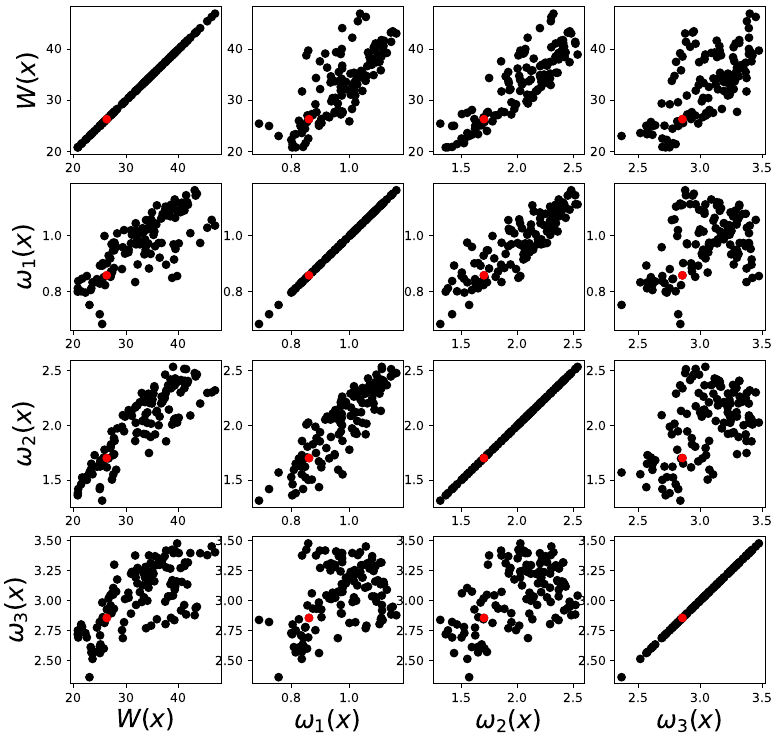
Figure 21. Scatter plot of the PF obtained for MOSOP4.